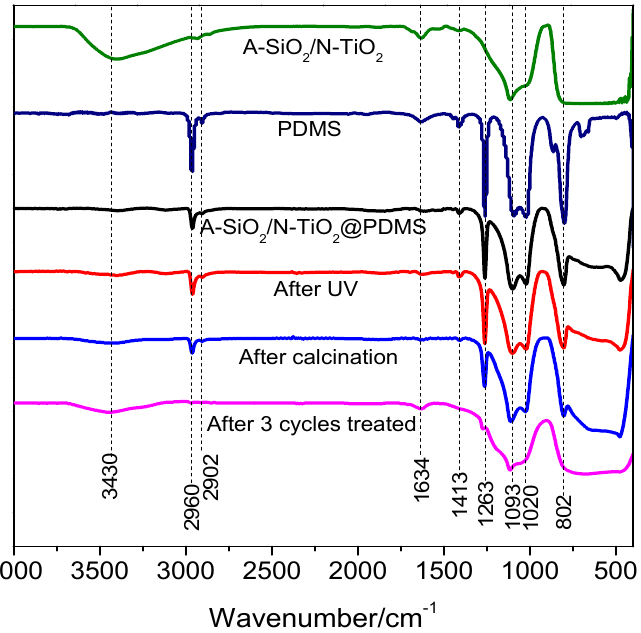
Figure 9. FT-IR spectra of A-SiO 2 /N-TiO 2 , PDMS, A-SiO 2 /N-TiO 2 @PDMS, and A-SiO 2 /N- TiO 2 @PDMS after UV irradiation; A-SiO 2 /N-TiO 2 @PDMS after calcination at 400 °C; and A-SiO 2 /N- TiO 2 @PDMS after 3 cycles of calcination and UV irradiation.